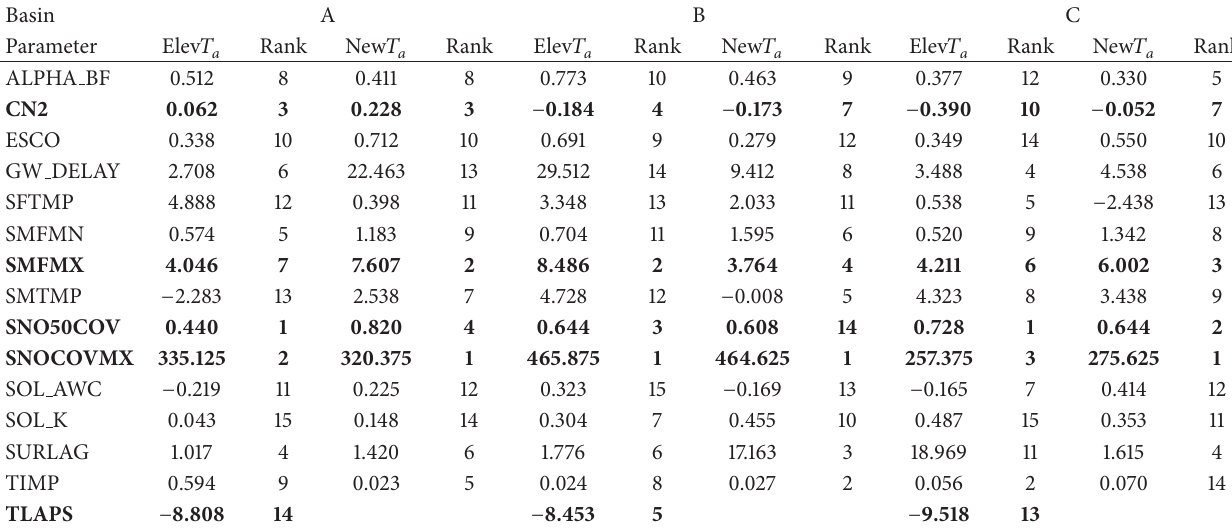
Figure 10: Spring snowmelt (March, April, and May) simulation results of least parameters setting (a) and complete parameters setting (b) of basin C. Table 9: Complete parameters set calibration results, for both Elev 𝑇 𝑎 and New 𝑇 𝑎